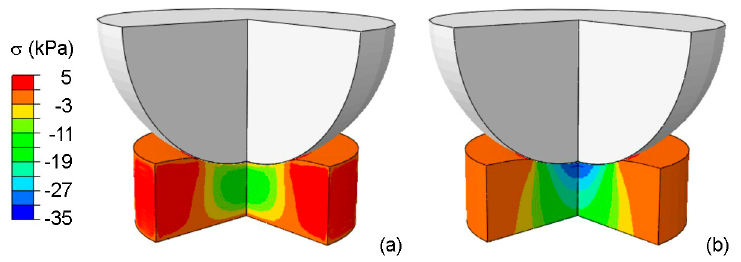
Figure 7. Contour of true stress σ (kPa) in the indentation direction at the end of ( a ) indentation and ( b ) consolidation of native PVA. ( b ) consolidation of native